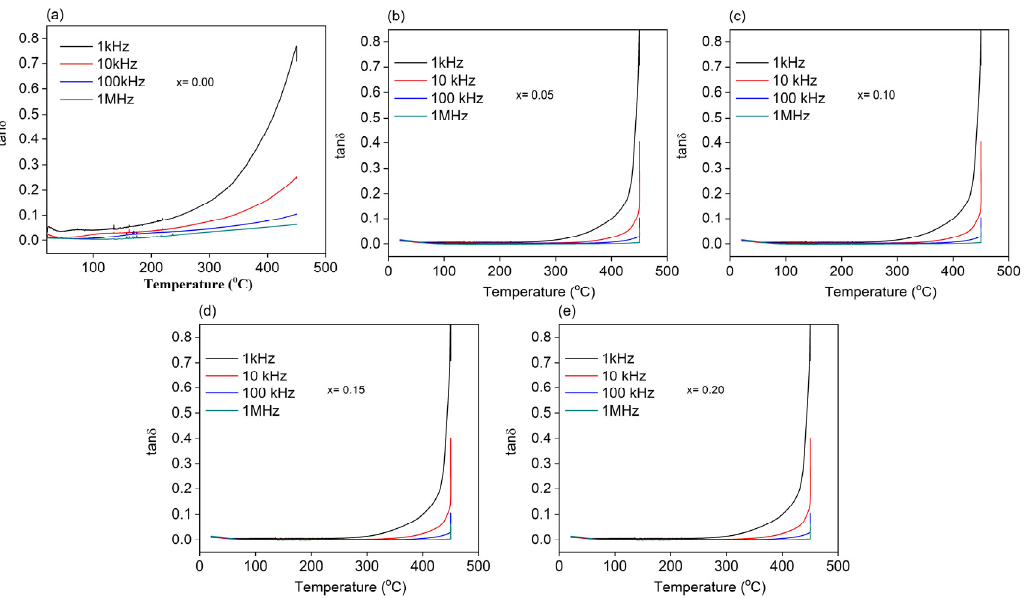
Figure 4. Variations in tan δ for ( NBT-BT-NBN 1 − x T x ) ceramic compositions: ( a ) x = 0.00, ( b ) x = 0.05, ( c ) x = 0.10, ( d ) x = 0.15, and ( e ) x = 0.2, as a function of the temperature with increasing frequencies.